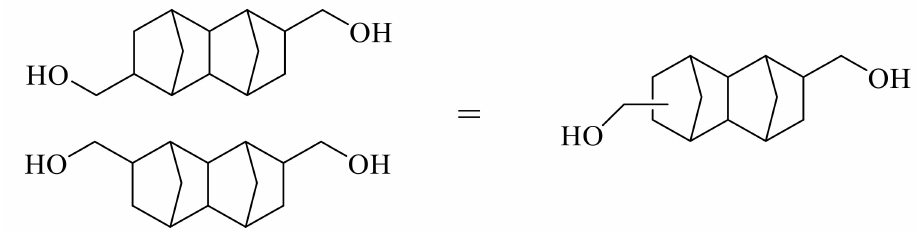
Figure 1. The structure of 2,6- and 2,7-isomers of DNDM.